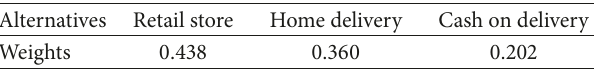
Table 8: Weights of sales